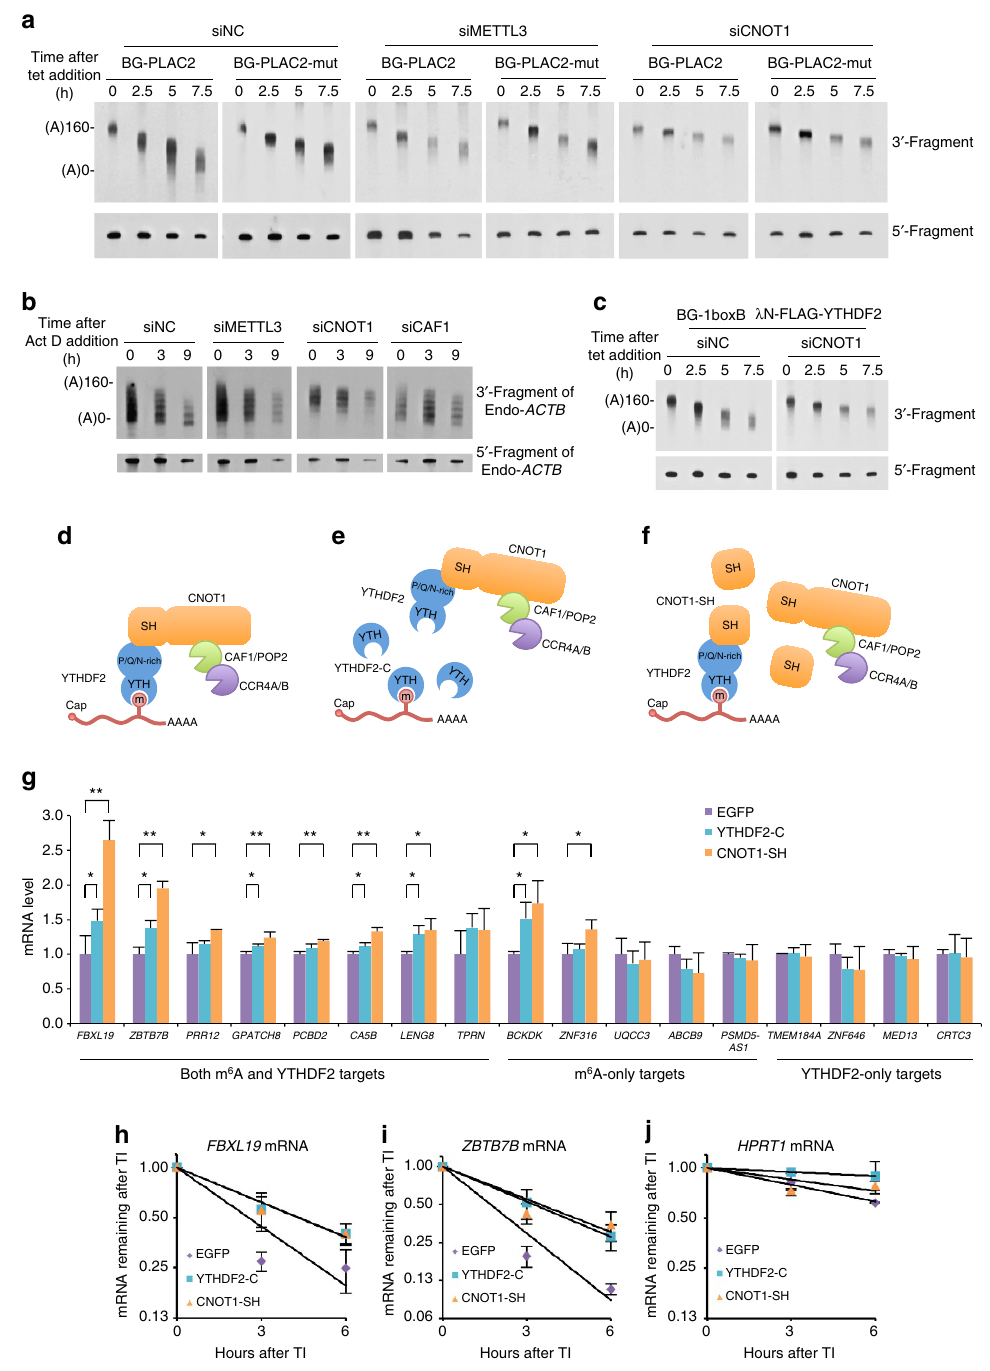
Figure 5 | Recruitment of CCR4–NOT through CNOT1 is essential for the degradation of endogenous m 6 A-containing RNAs. ( a ) Deadenylation assay of BG-PLAC2 and BG-PLAC2-mut on knocking down of endogenous METTL3 or CNOT1 by siRNA. siNC served as a negative control. ( b ) Deadenylation assay of endogenous ACTB mRNA on knocking down of endogenous METTL3, CNOT1 or CAF1 by siRNA. ( c ) Deadenylation assay of BG-1boxB mRNA in the presence of l N-FLAG-YTHDF2 on knocking down of endogenous CNOT1 by siRNA. ( d – f ) Schematic diagrams of YTHDF2-mediated deadenylation of m 6 A-containing RNAs and the dominant-negative effect of YTHDF2-C or CNOT1-SH. m 6 A is recognized by YTHDF2, which further recruits the CCR4–NOT complex by interacting with CNOT1 ( d ). Overexpressed YTHDF2-C occupies m 6 A sites but is incapable of recruiting the CNOT1 subunit of the CCR4–NOT complex; thus, it impairs the deadenylation and decay of m 6 A-containing RNAs ( e ). Overexpressed CNOT1-SH binds to endogenous YTHDF2 but is incapable of recruiting the catalytic subunits CAF1 and CCR4A/B; thus, it impairs the deadenylation and decay of m 6 A-containing RNAs ( f ). ( g ) Expression level of endogenous target mRNAs measured by quantitative reverse transcriptase–PCR on overexpression of YTHDF2-C, CNOT1-SH or the negative control green fluorescent protein (EGFP). All values were normalized to HPRT1 mRNA, a housekeeping gene previously reported to contain no m 6 A modifications and is not bound by YTHDF2. Error bars, mean ± s.d., n ¼ 3, biological replicates. ** P o 0.01, * P o 0.05, t -test. ( h – j ) Half-life of FBXL19 , ZBTB7B and HPRT1 mRNA on overexpression of YTHDF2-C, CNOT1-SH or the negative control EGFP after transcription inhibition (TI). All values were normalized to 18S rRNA. Error bars, mean ± s.d., n ¼ 3, biological